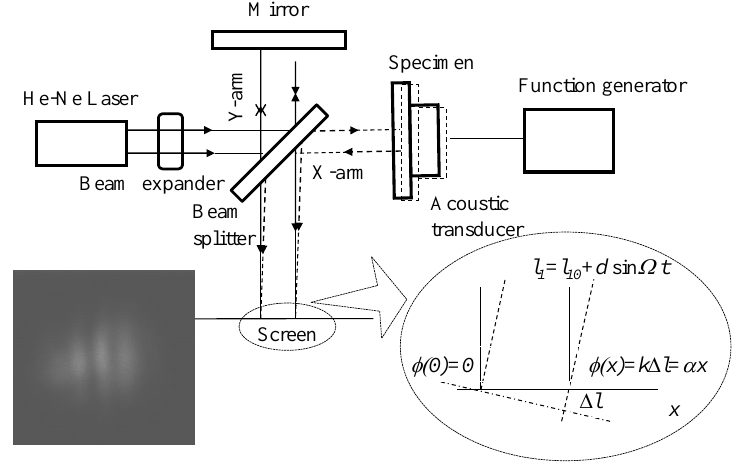
Figure 2. Experimental arrangement with a Michelson-type interferometer. The function generator (Gold Star Model FG 8002) sends sinusoidal input voltage to the acoustic transducer (magnetic type, Design Factory Dokodemo-Speaker